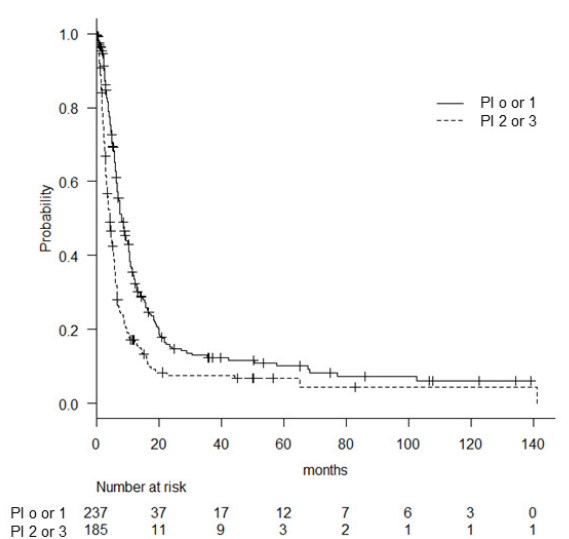
Figure 4. The overall survival (OS) of the patients with stage IV B disease stratified by the Prognostic